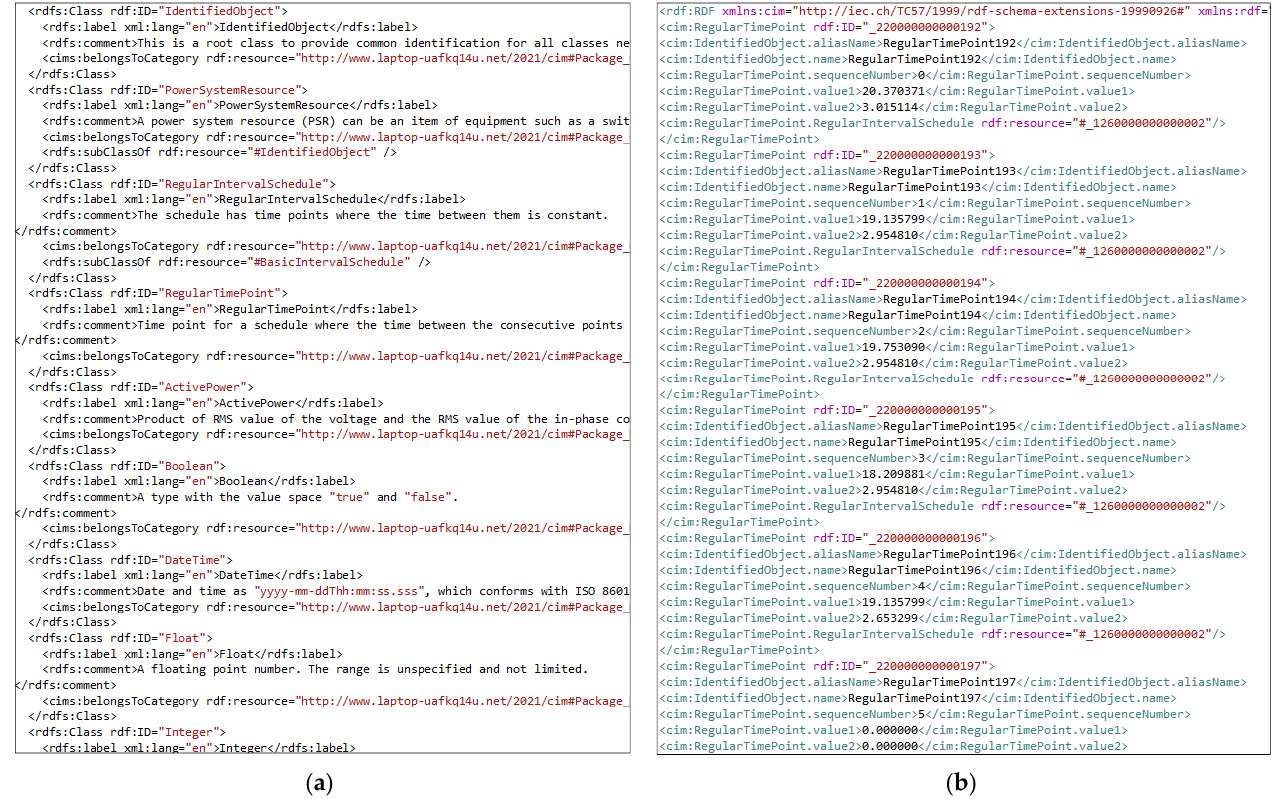
Figure 14. A UML diagram of the prediction of generation and load.